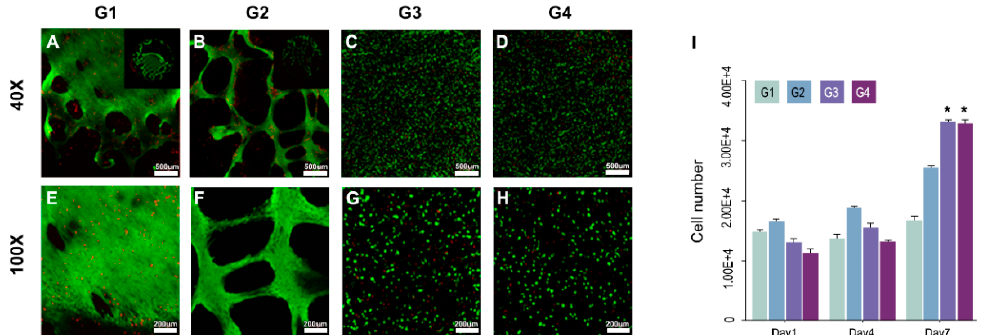
Figure 3. Cell viability and proliferation test. Live and dead assay results of cell-printed structure at day 1, magnification 100×, green dot: live cell, red dot: dead cell (scale bar: 500 μ m and 200 μ m). ( A , B , E , F ) cell seeding group showed irregular distribution; ( C , D , G , H ) bioprinting group showed well distribution of cells.; ( I ) In the CCK-8 assay, shear stress occurred during printing, and cell viability was lower than that of the cell seeding group on day 1 but showed no significant difference (G1, G2). However, proliferation of cell printing group (G3 and G4) has occurred to a good extent on day 7. * p < 0.05.